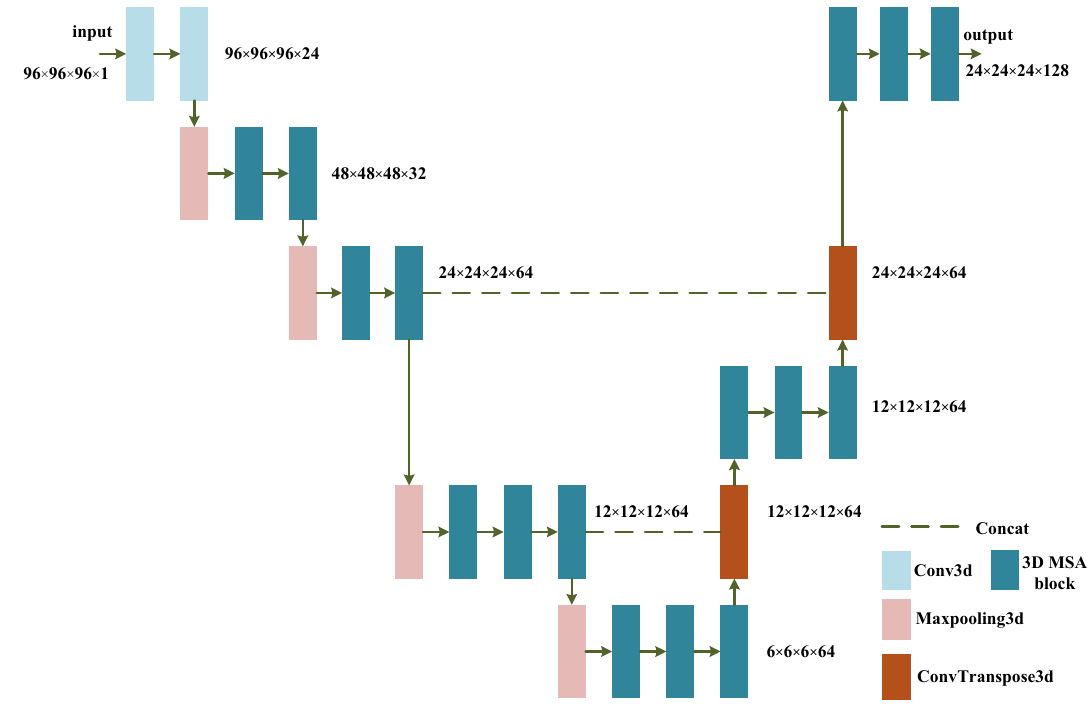
Figure 4. The structure of the feature extraction network based on 3D MSA blocks. The size of feature map is written in the form of (#length × #width × #height × #channel), such as (96 × 96 × 96 ×